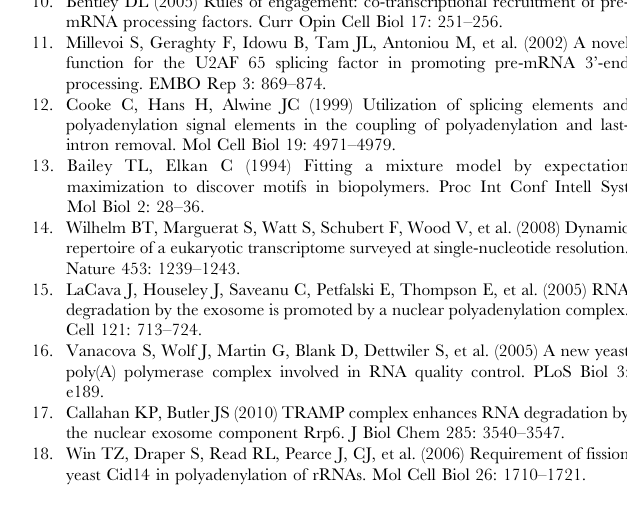
Figure S6 Synchronized meiosis. Diploid pat1–114/pat1–114 cells (F277) were induced to enter a synchronous meiosis. Cells were stained with DAPI to visualize nuclei and 200 cells from each sample were counted and these data are shown. Meiotic DNA synthesis was between 2 and 4 hr after induction (based on flow cytometry, data not shown), the first meiotic division was around 5 hr, and the second meiotic division was around 6 hr. Table S1 Strain list. Strain names in parenthesis are the original name from the requested laboratory or from Yeast Genetic Resource Center (YGRC, Japan, FY strains). Table S2 Primer list. Table S3 Normalized expression microarray